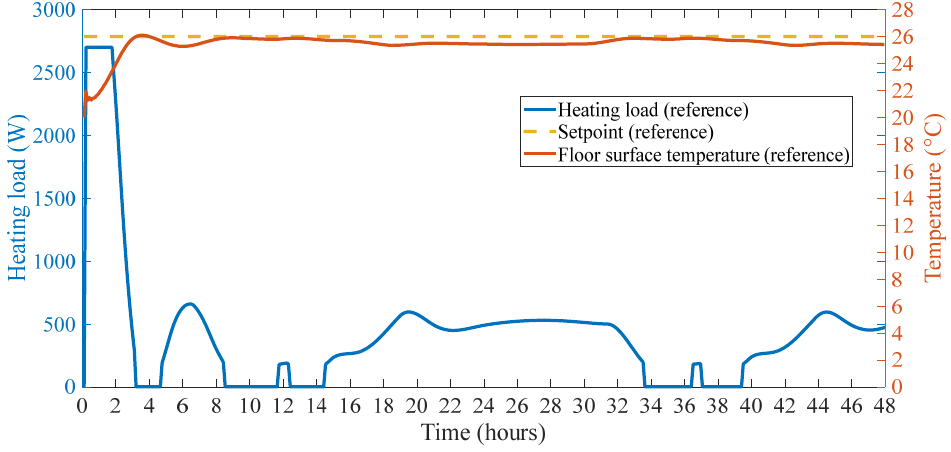
Figure 20. Reference case for floor surface temperature control with solar radiation.